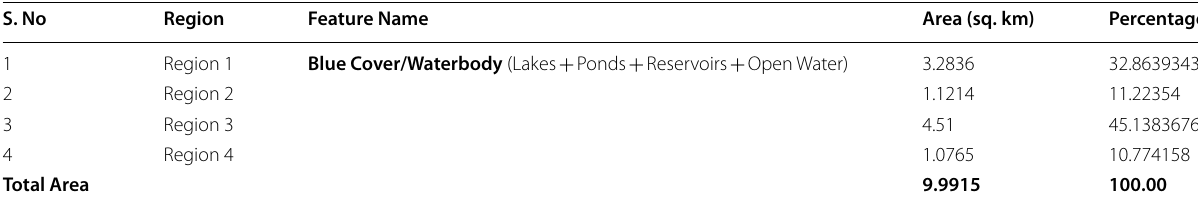
Table 7 Distribution of blue spaces across a selected area S. No